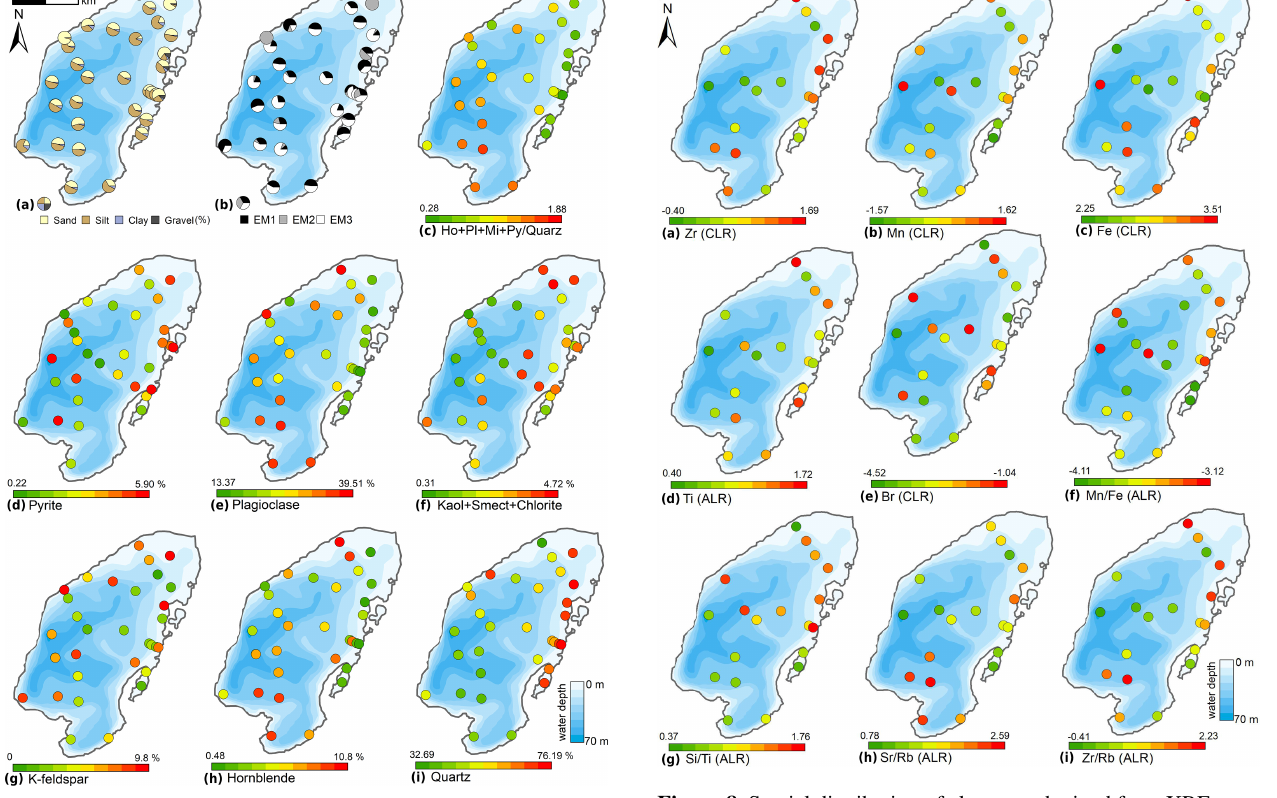
Figure 7. Spatial distribution of the grain-size and mineral com- positions of the surface sediments of Lake Bolshoe Toko. Maps compiled in ArcGIS 10.4. Scales chosen as 10 classes with equal intervals.